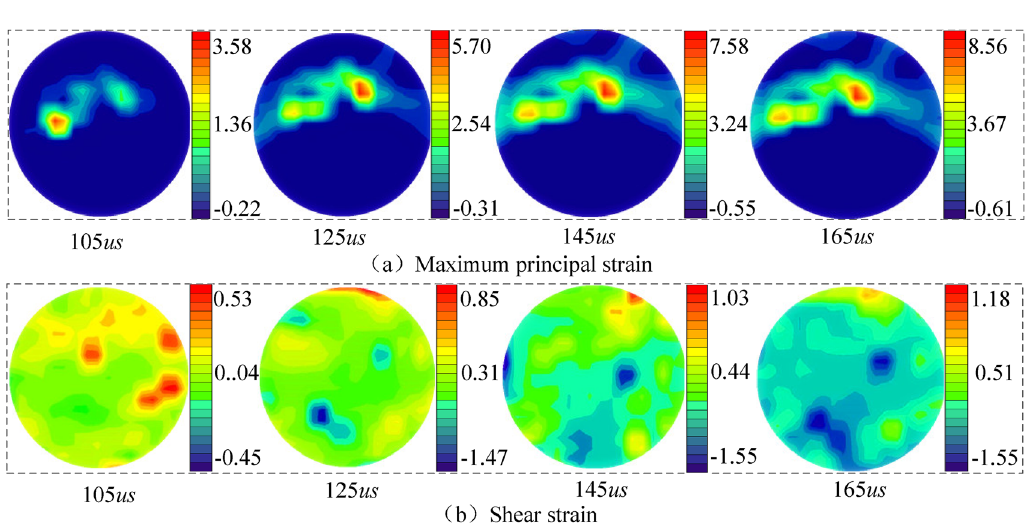
Figure 11. Strain field distribution in saturated coal samples at a loading pressure of 0.30